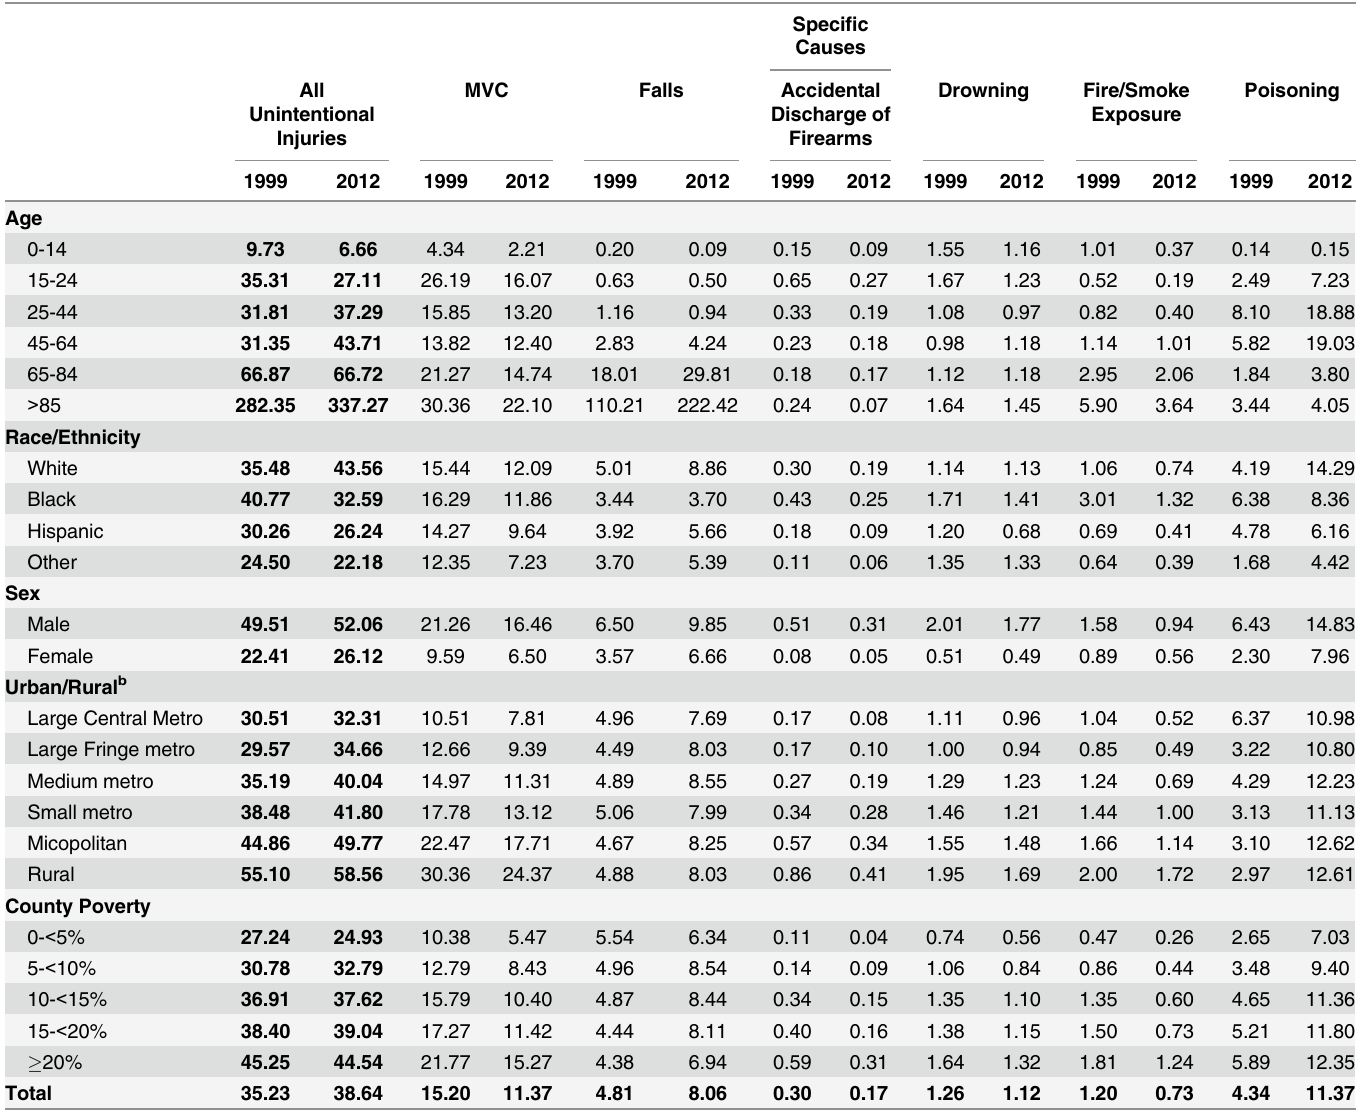
Table 1. Mortality Rates (per 100,000)a for All Unintentional Injuries and Specific Causes, US 1999 –